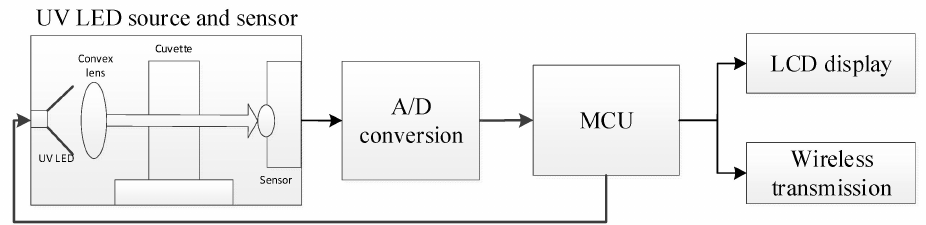
Figure 1. Structure diagram of the portable photoelectric detection system based on wireless